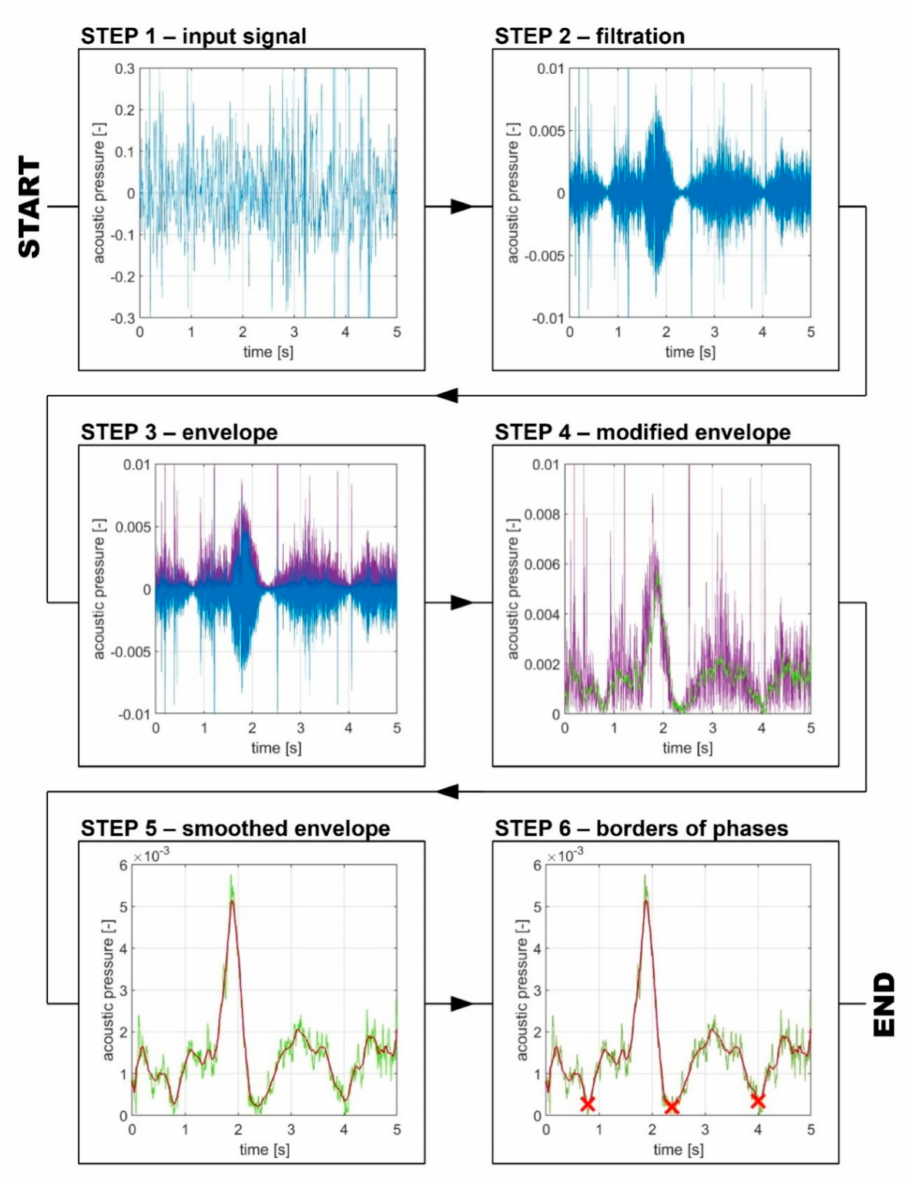
Figure 2. A flow-chart of the proposed algorithm. STEP 1: upload and visualization of the sound recording. STEP 2: use of high-pass and low-pass filter to remove ambient noise. STEP 3: finding of the positive envelope of the signal. STEP 4: Modification of the envelope. STEP 5: smoothing of the modified curve. STEP 6: finding of the borders of the respiratory phases as a minimum values of the